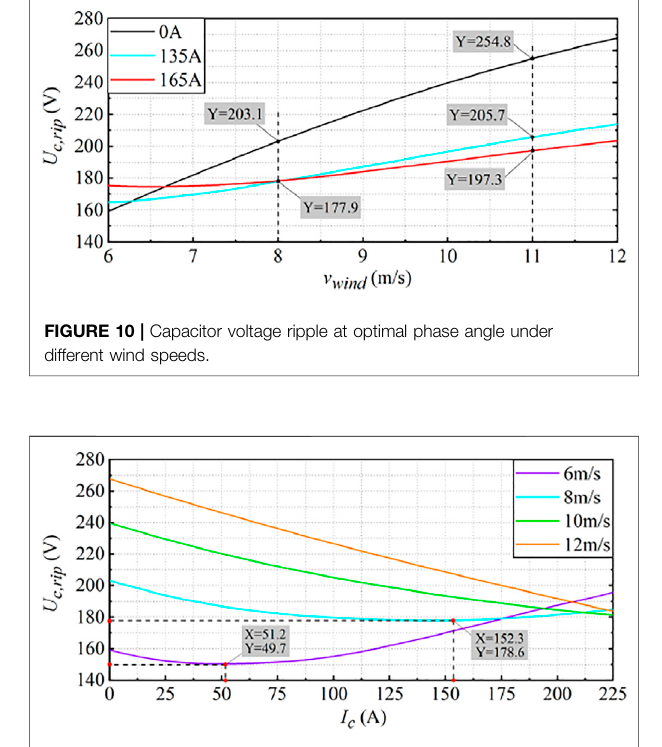
FIGURE 11 | Capacitor voltage ripple under different circulating current